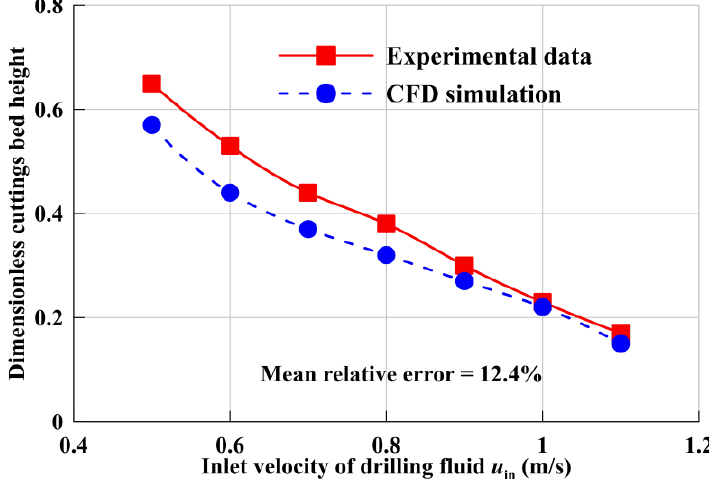
Figure 3. Comparison between simulated and experimented cuttings bed height.